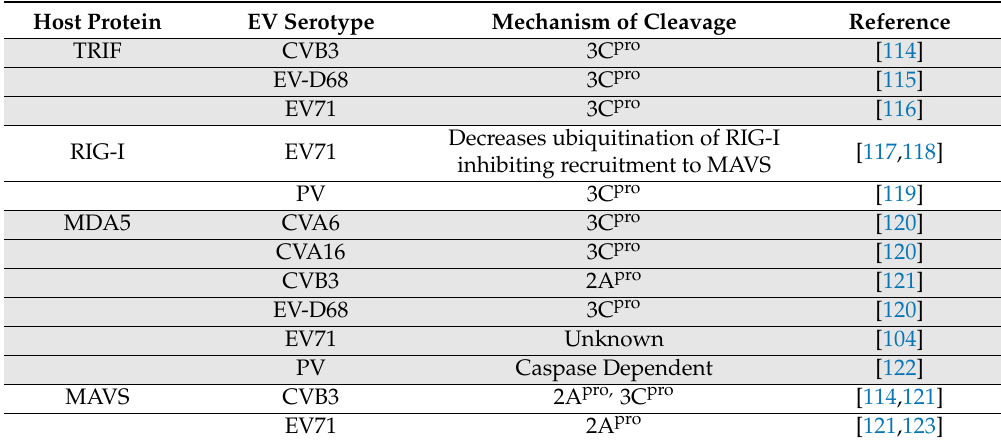
Table 2. Enterovirus targets of